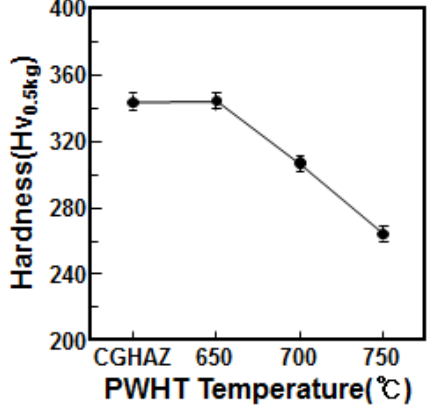
Figure 10. Comparison of matrix hardness at various PWHT temperatures.